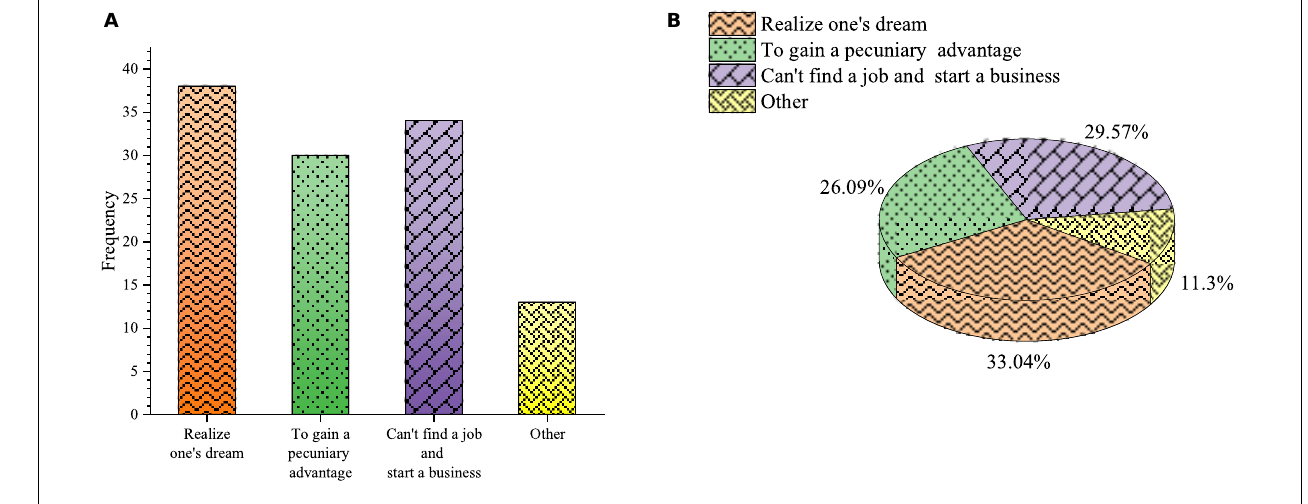
FIGURE 6 | College students’ entrepreneurial motivation (A) frequency; (B) percentage.